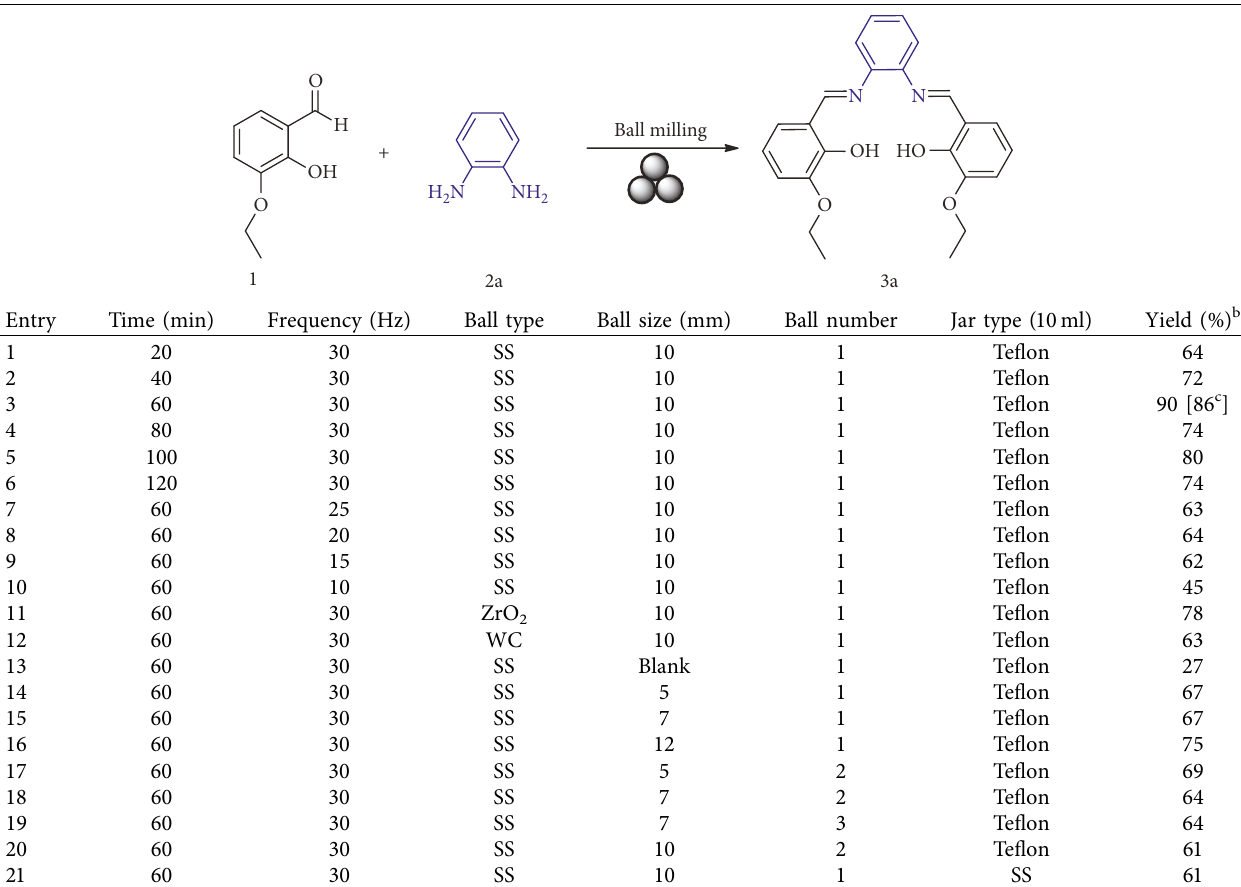
Table 1: Optimization of the mechanochemical ball milling conditions for Salophen synthesis a